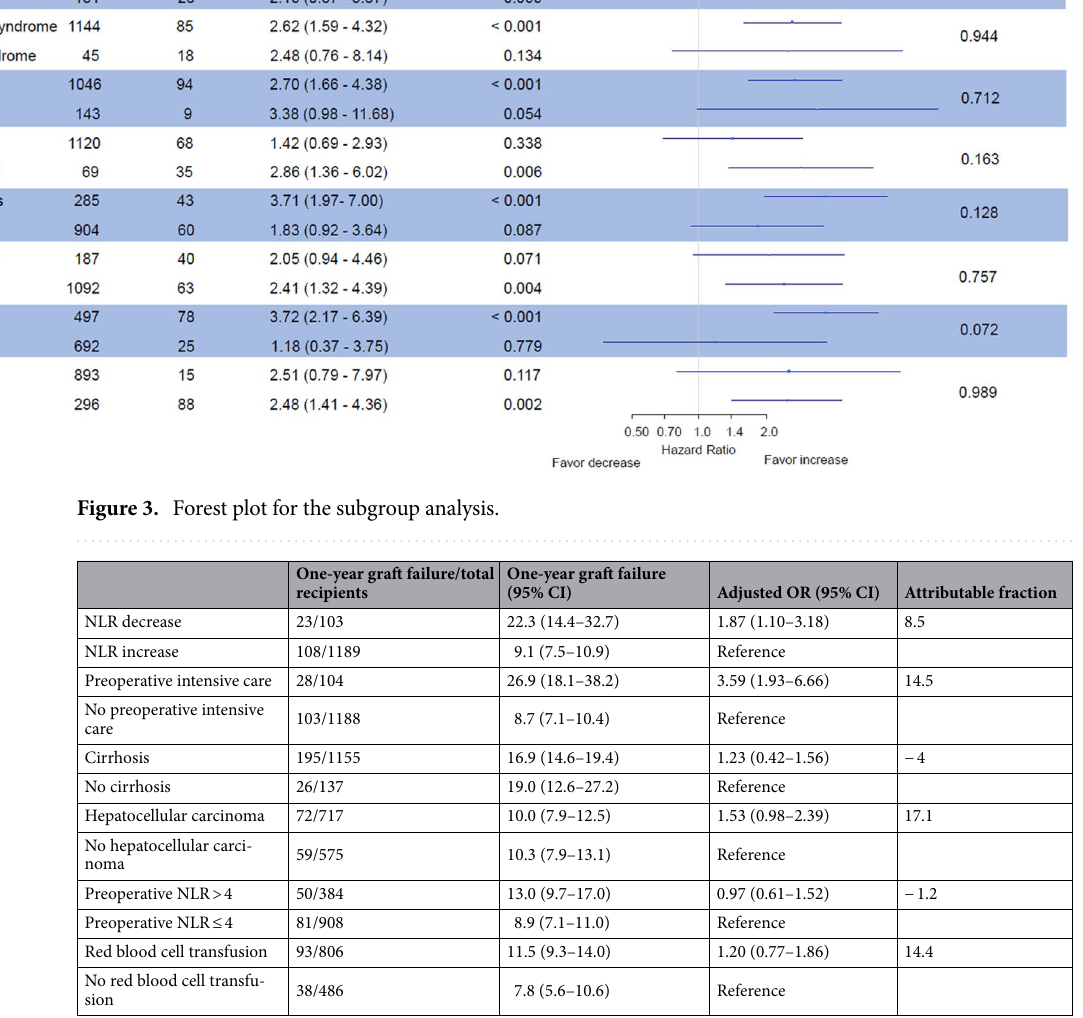
Table 3. Attributable fraction of variables on 1-year graft failure after living donor liver transplantation. NLR neutrophil-to-lymphocyte ratio, OR odds ratio, CI confidence interval. The attributable fraction is a measure that represents the proportional reduction in the incidence of graft failure within a population that would occur if the variable was absent, provided that a causal relation existed between that variable and the incidence of graft failure. We used incidence of variable and the association between the variable and the incidence of graft failure to calculate the attributable fraction.